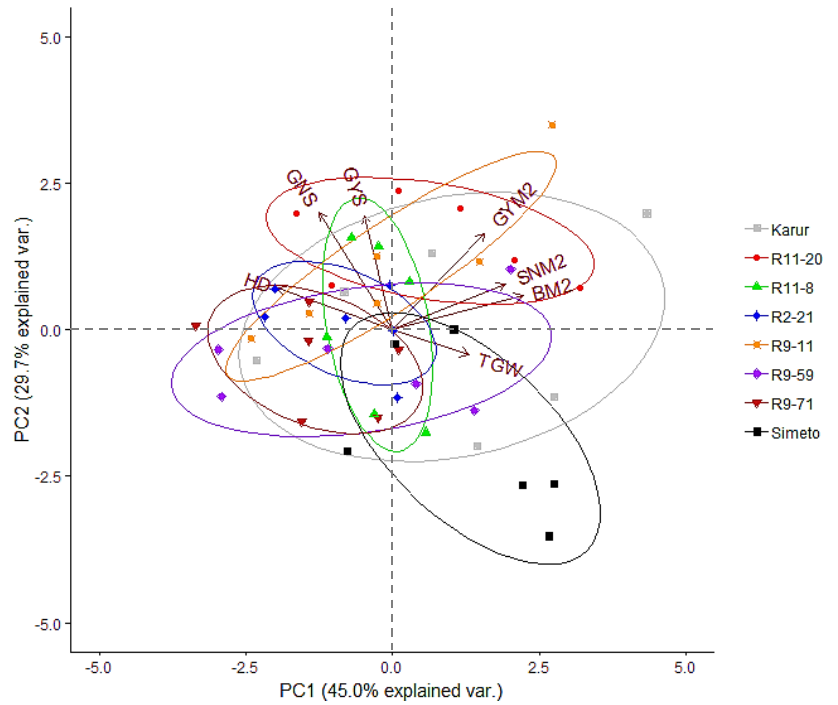
Figure 2. Bi-plot of the first two axes of principal component analysis for the main yield components of the eight genotypes analysed in 2015 and 2016 (GYM2, grain yield m − 2 ; BM2, biomass m − 2 ; SNM2, spike number m − 2 ; TGW, thousand grain weight; GNS, grain number spike − 1 ; GYS, grain yield spike − 1 ; HD, heading date).